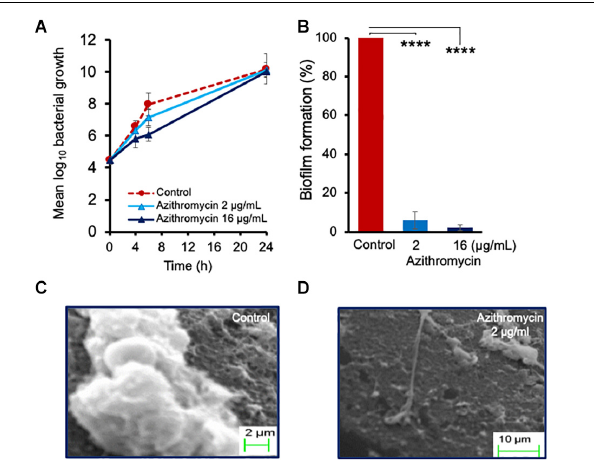
FIGURE 2 | Activity of azithromycin against planktonic cells of P. aeruginosa PA14 (A) , and biofilm formation (B) at 24 h. Scanning electron micrographs revealing biofilm formation at 24 h in absence of drug (C) or in presence of azithromycin (D) . The catheter piece in drug-free control well shows production of extracellular matrix and biofilm formation, while no extracellular biofilm matrix and biofilm formation observed in presence of azithromycin. Each value is the average of triplicate assay where presented data is mean ± SD. Statistical analysis were calculated using one way ANOVA and **** p < 0.0001 ( n =